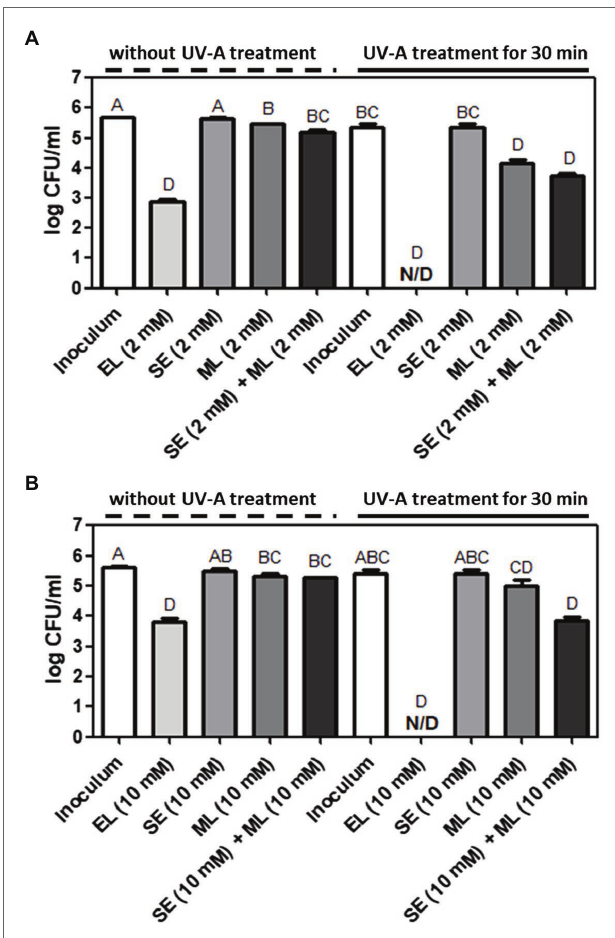
FIGURE 2 | Comparison of antibacterial activities among EL, sodium erythorbate (SE), monolaurin (ML), and SE/ML mixture with or without UVA light treatment against (A) L. innocua and (B) E. coli O157:H7. The mean values from three independent measurements are shown. N/D, not detected. Different uppercase letters indicate significant differences ( p ≤